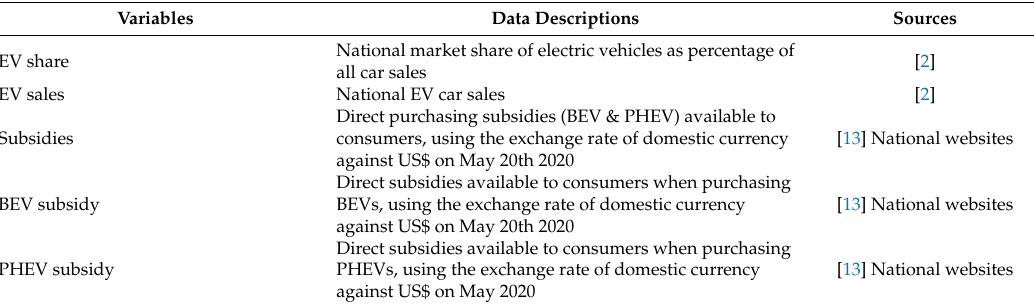
Table A1. Description of variables and